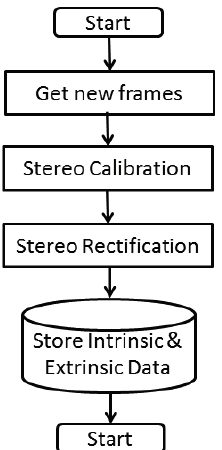
Figure 7. Flow chart initial stage.